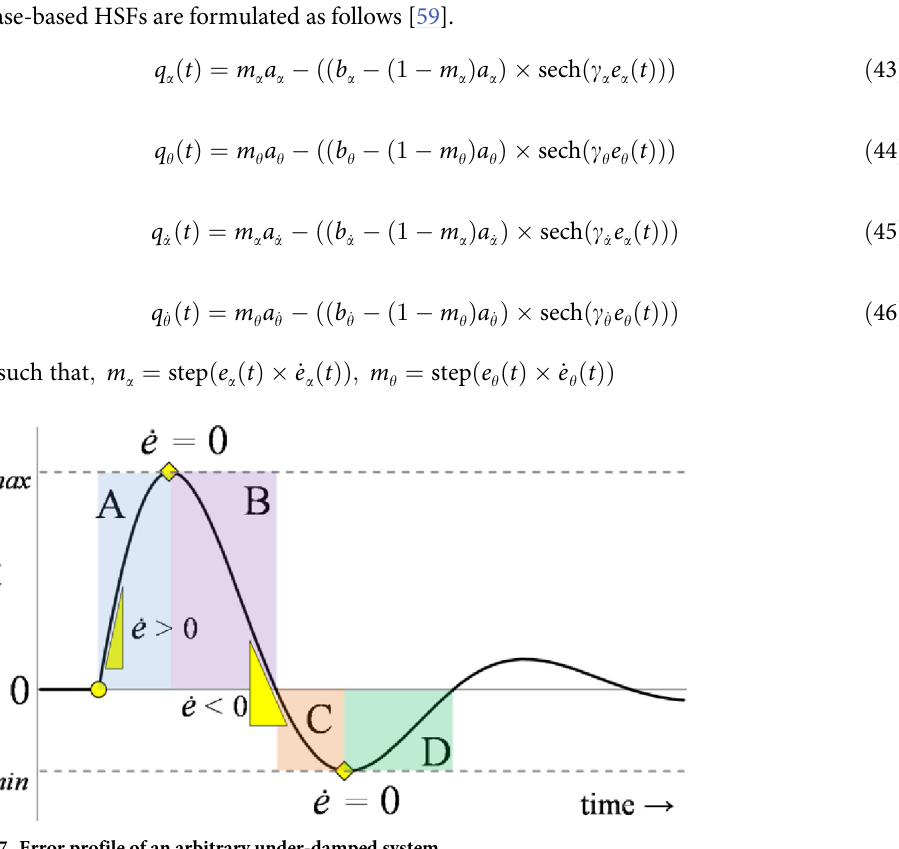
Fig 7. Error profile of an arbitrary under-damped